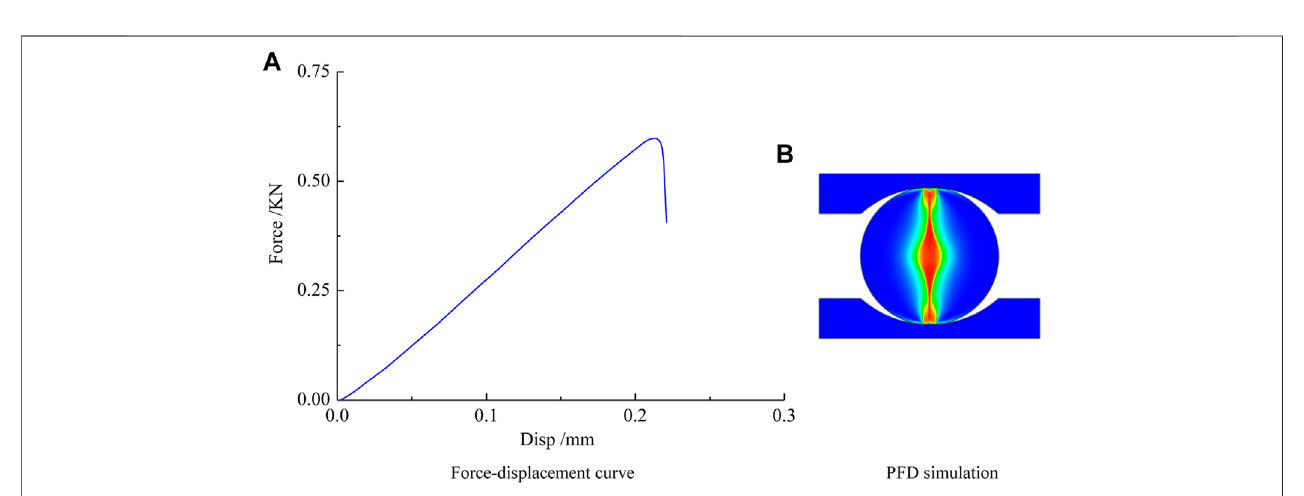
FIGURE 3 | PFD simulation of Brazilian splitting mechanical responses of the intact sample.